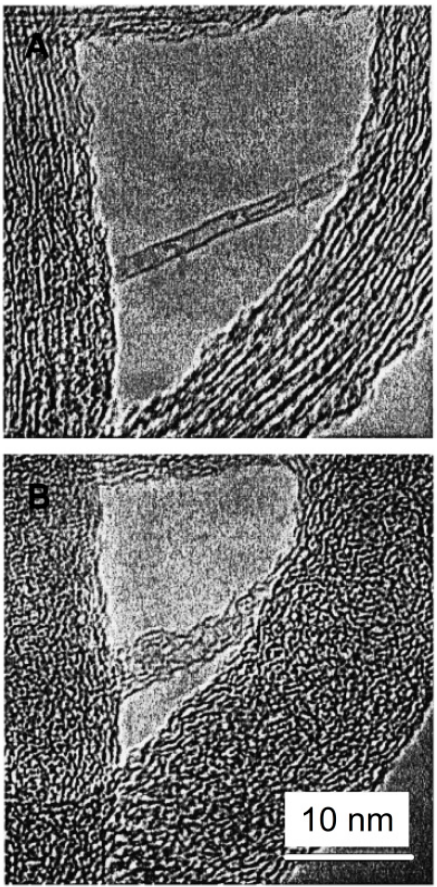
Figure 34. Electron irradiation of a SWNT at 200 keV: ( A ) before extensive irradiation and ( B ) after irradiation to a dose of 0.35 × 10 23 electrons/cm − 2 . Reproduced with permission from Smith et al. [117]. Copyright American Physical Society, 2001.